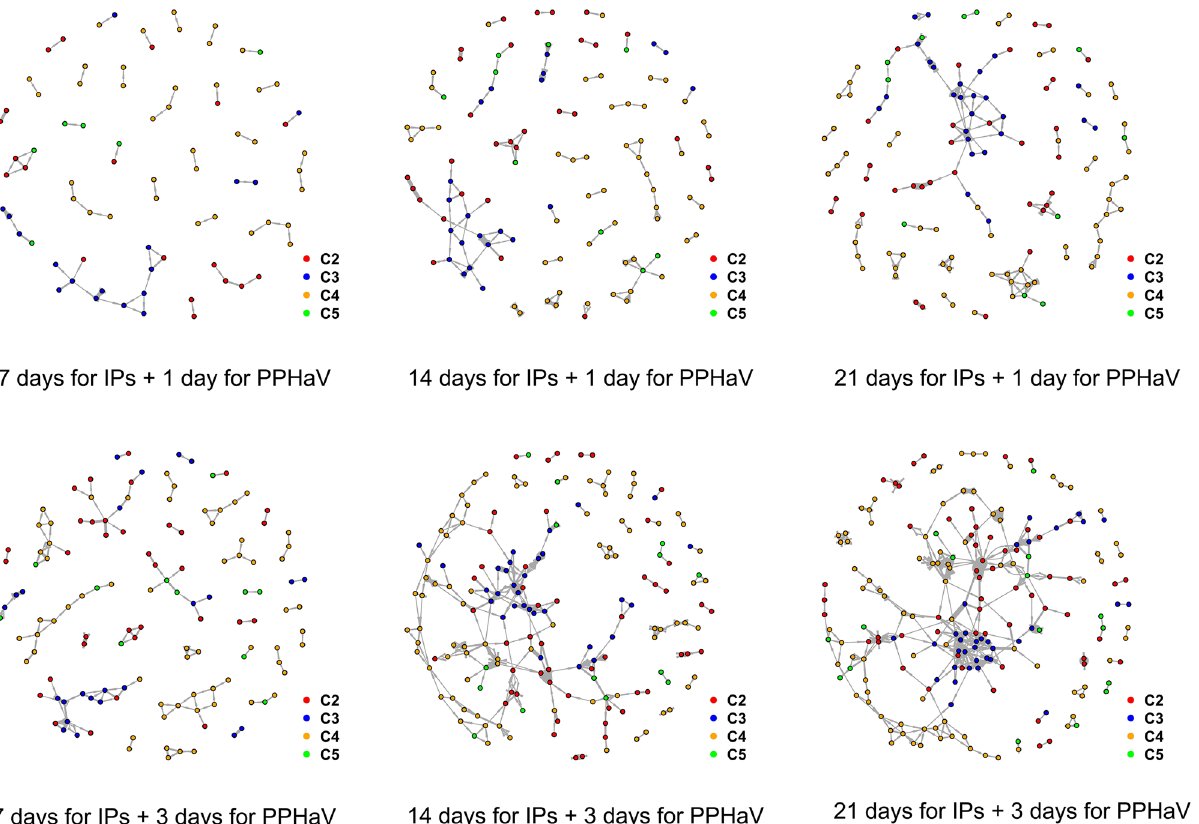
Figure 1. Graphical representation of networks consisting of all infected premises (IPs), constructed by under different temporal assumption on infectious duration for IPs and poultry production and health associated vehicle (PPHaV) movements . Each of figures represent the contact network between IPs, under the different infectious duration for IPs and vehicle movement. The plots in the top row display one day infectious duration for vehicle movement with seven days infectious duration for IPs (top left), 14 days duration (top middle), and 21 days duration for IPs (top right). The plots in the bottom rows depict three days duration for vehicle movement with seven days infectious duration for IPs (bottom left), 14 days duration (bottom middle), and 21 days duration for IPs (bottom right). Colored dot denotes specific genotype IPs; red for C2, blue for C3, yellow for C4 and green for C5. Coefficient estimates ( p value) Farm Species Poultry integrator Spatial distance Infectious duration for IPs + PPHaV BIC (ref. = different) (ref. = different) (unit =